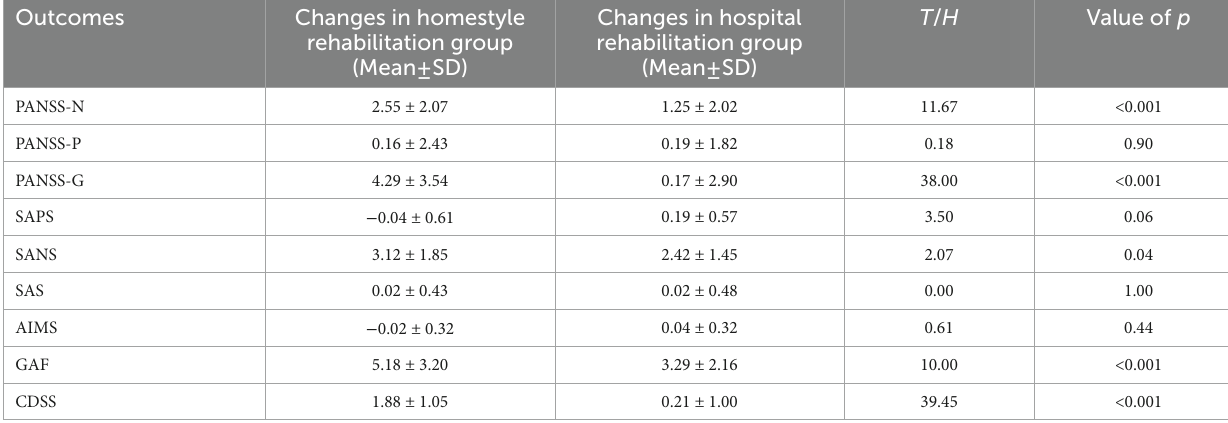
PANSS, Positive and Negative Syndrome Scale; SAPS, Scale for the Assessment of Positive Symptoms; SANS, Scale for the Assessment of Negative Symptoms; CDSS, Clinical Decision Support Systems; SAS, Self-Rating Anxiety Scale; AIMS, Abnormal Involuntary Movement Scale; GAF, Global Assessment of Functioning; SD, Standard Deviation; H , the statistic of Kruskal-Wallis test; T , the statistic of t -test. TABLE 4 The regression analysis of changes of CDSS, SAS, SAPS and AIMS for the SANS. Dependent variable ( n = 97)